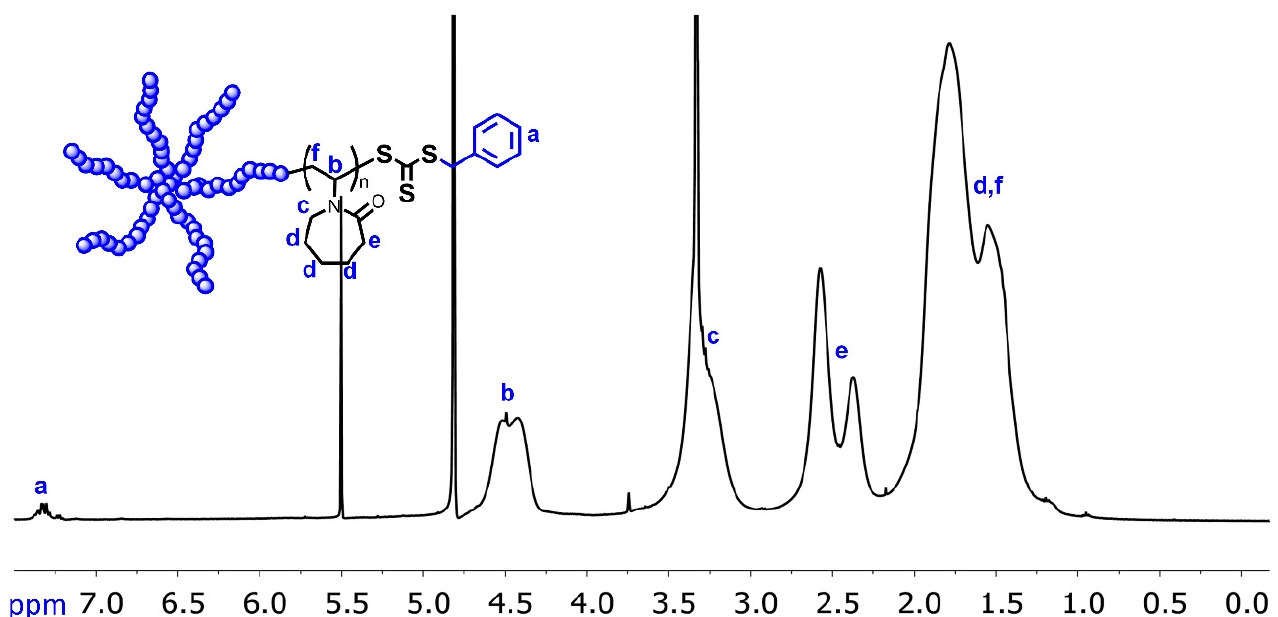
Figure 7. 1 H-NMR (400 MHz) spectrum of (PNVCL-trithiocarbonate) 6 six-arm polymers in CD 3 OD.